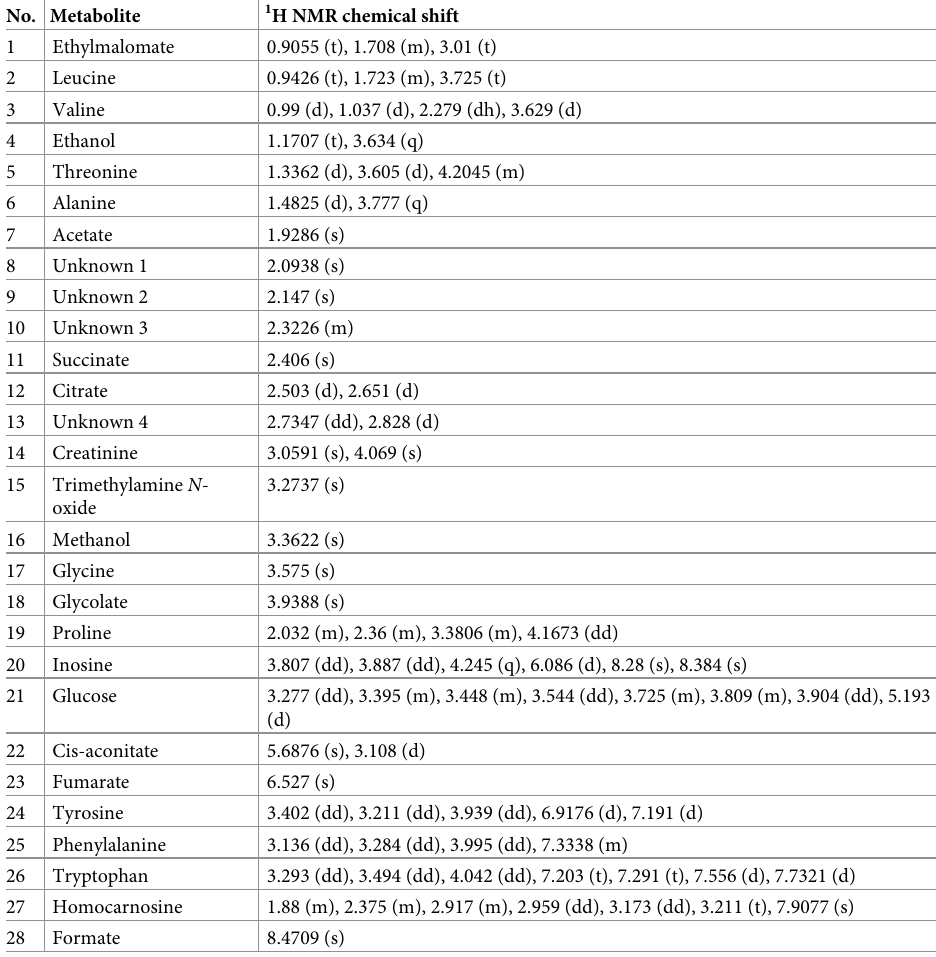
Table 1. List of identified metabolites in the SPMAP09 strain after crystallization in AU.